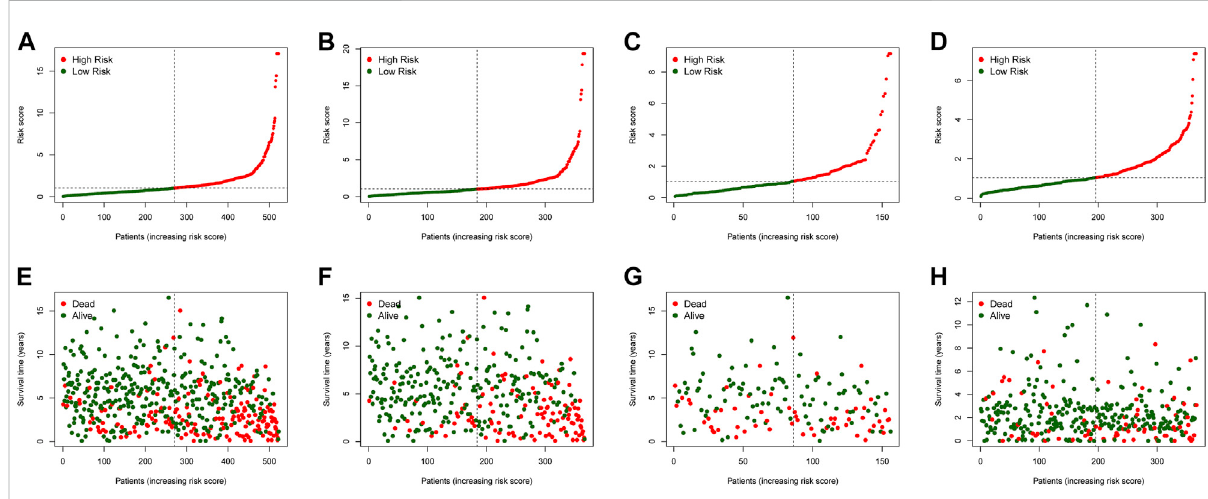
FIGURE 4 TheriskscoredistributionandCOADcancerpatients ’ survivalstatusinthetrainingcohort (A,E) ,testcohort (B,F) ,allpatients (C,G) ,andvalidation cohort (D,H) based on the risk score of the 4-gene signature.